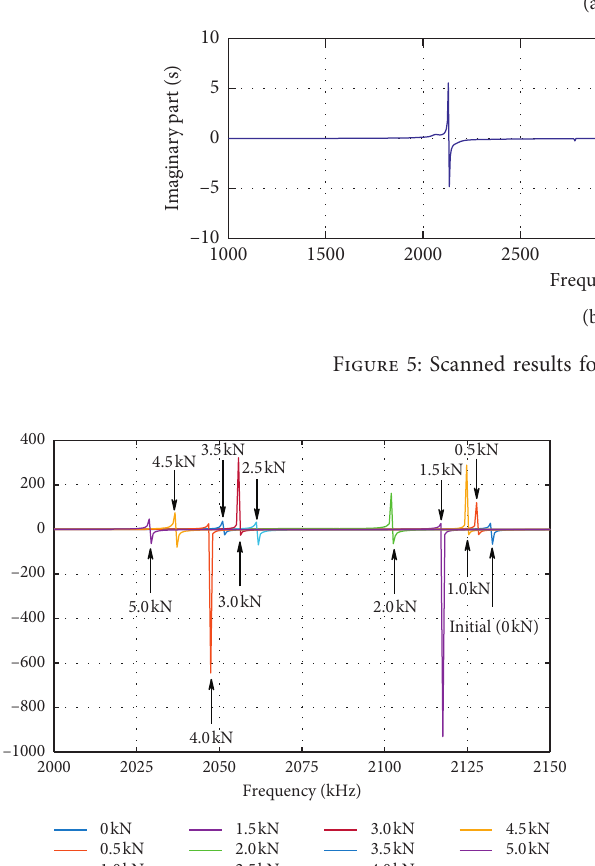
Figure 7: Frequencies corresponding to the peak and trough of the admittance signature between 2000kHz and 2150kHz